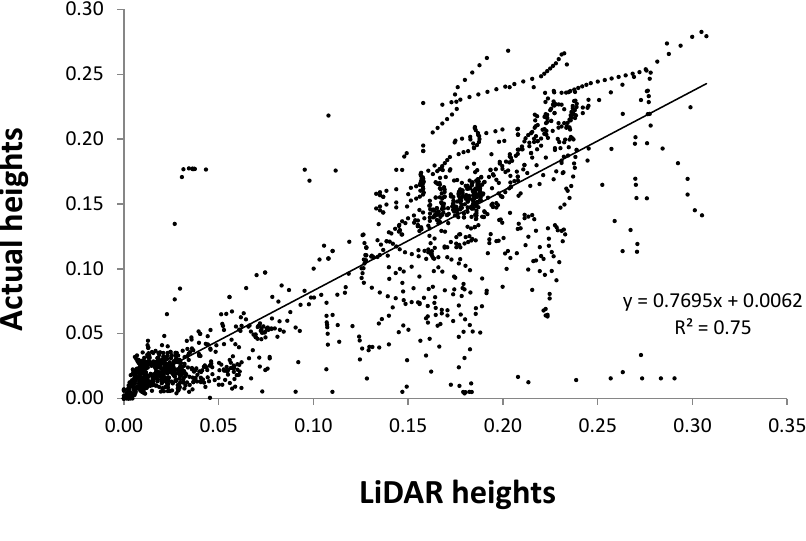
Figure 2. Linear regression between actual plant height (m) and LIDAR measured height.